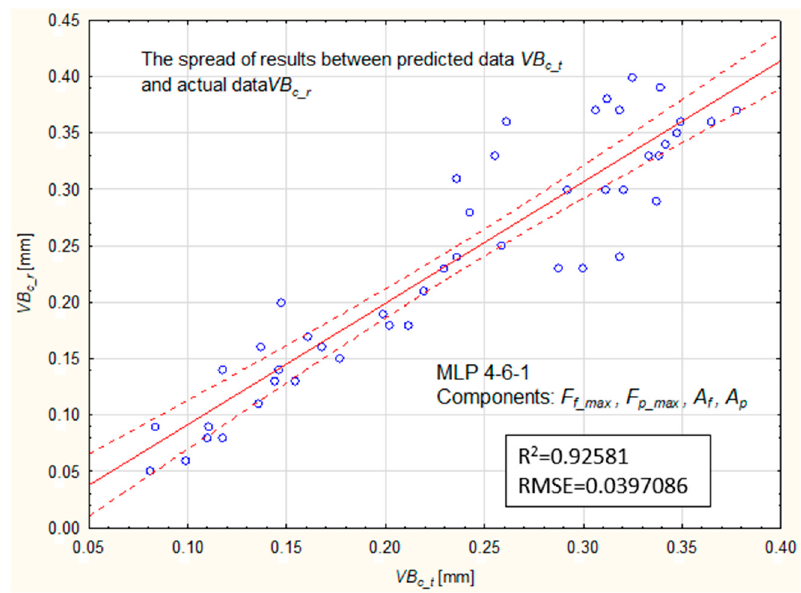
Figure 13. Comparison of predicted values, VBc_t, with experimental data, VBc_r, at the validation stage MLP 4-6-1 (based on Fp_max, Ff_max, Af, and Ap variables).